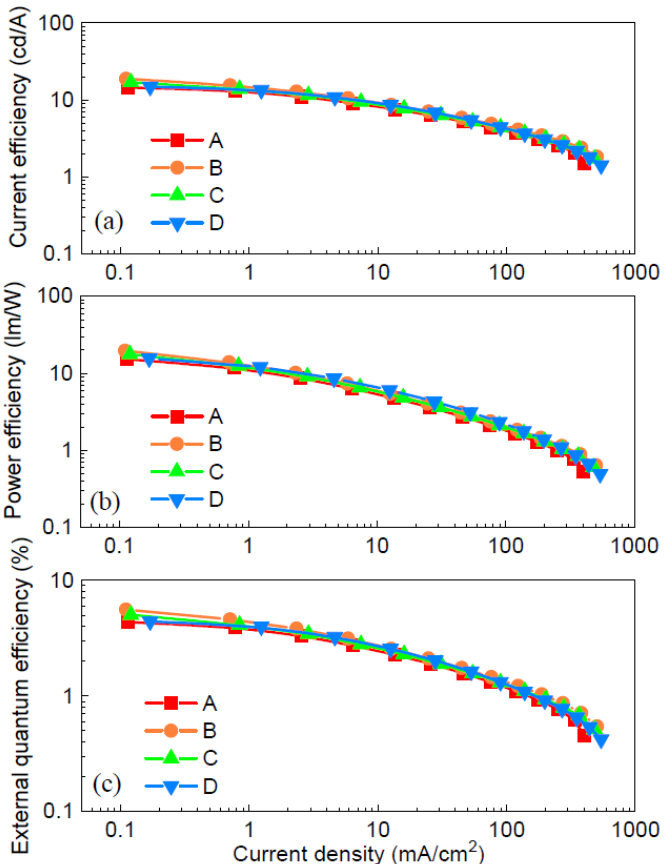
Figure 6. (a ) Current efficiency, ( b ) power efficiency, and ( c ) external quantum efficiency (EQE) curves of the